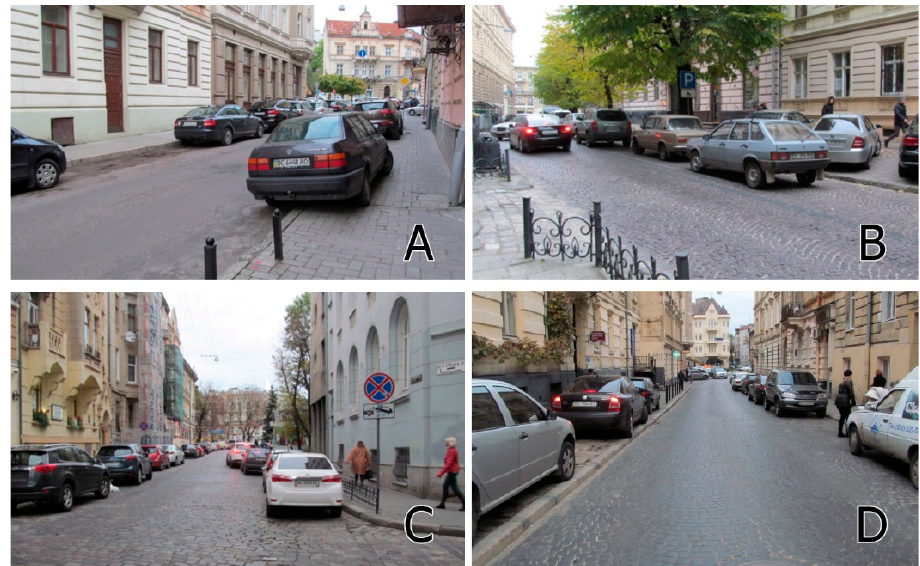
Figure 5. Typical on-street parking situations in the central part of Lviv in 2016: ( A ) parking on part of the sidewalk; ( B ) double parking; ( C ) parking under the prohibition sign; ( D ) parking on the entire sidewalk. Photo by R. Liubytskyi. Table 2. Results of the on-street parking field survey in the city center, 2016.